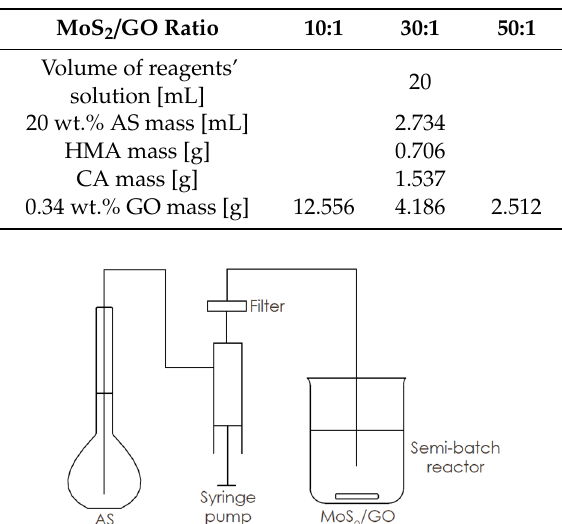
/ graphene oxide (GO) in the semi-batch